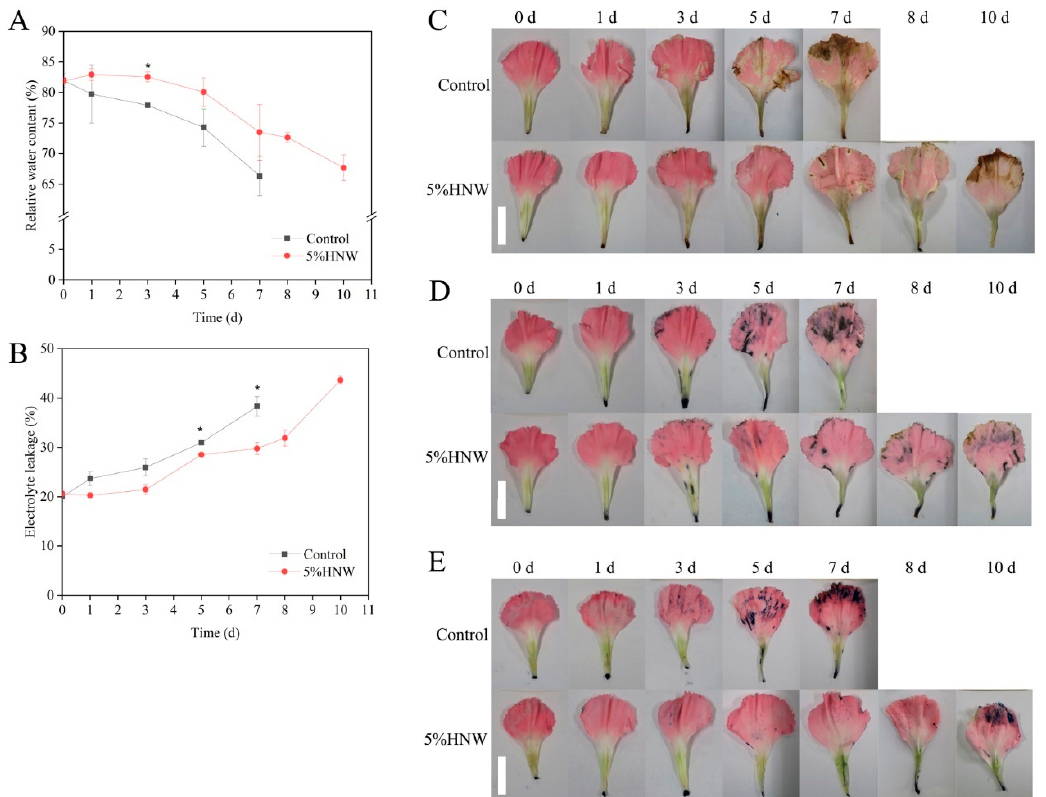
Figure 3. Changes in relative water content (RWC; ( A )), electrolyte leakage ( B ), hydrogen peroxide (H 2 O 2 ; ( C )), and superoxide anions (O 2 − ; ( D )) accumulation as well as cell death ( E ) of carnation petals during vase period. Cut flowers were incubated in distilled water (control) and 5% HNW, respectively, for 3 d (changed daily), and then, in distilled water, which was replaced daily until the end of experiments. Values were expressed as the means ± SE. Asterisks indicated significant differences at p < 0.05 by t -test. The petals were stained with 3,3-diaminobenzidine (DAB; ( C )), nitro blue tetrazolium (NBT; ( D )), and trypan blue ( E ), respectively, then photographed with digital camera. Scale bar = 4 cm. Three flowers per replicate were selected, and total flowers in triplicate were 9 (3 × 3) for each treatment at each time point, then photographed.